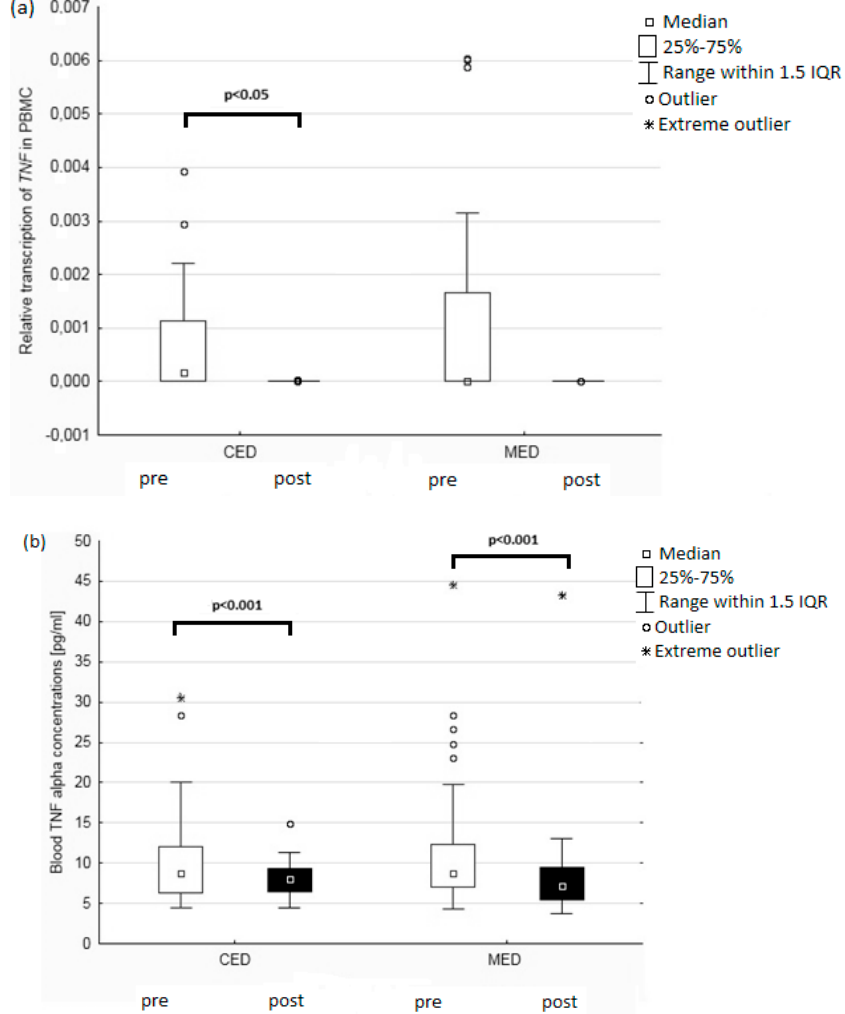
Figure 2. The mRNA levels of TNF expression in PBMCs ( a ) and blood TNF α concentrations ( b ) pre and post the intervention among 95 postmenopausal women. Boxplots shows median values and interquartile ranges. Circles represent outliers that extend more than 1.5 box-lengths from the edge of the box, and stars represent extreme outliers which extend more than three box-lengths. The differences between the parameters before and after the dietary intervention were assessed using the Wilcoxon test. PBMC: peripheral blood mononuclear cells; CED: Central European diet; MED: Mediterranean diet; IQR: interquartile range.